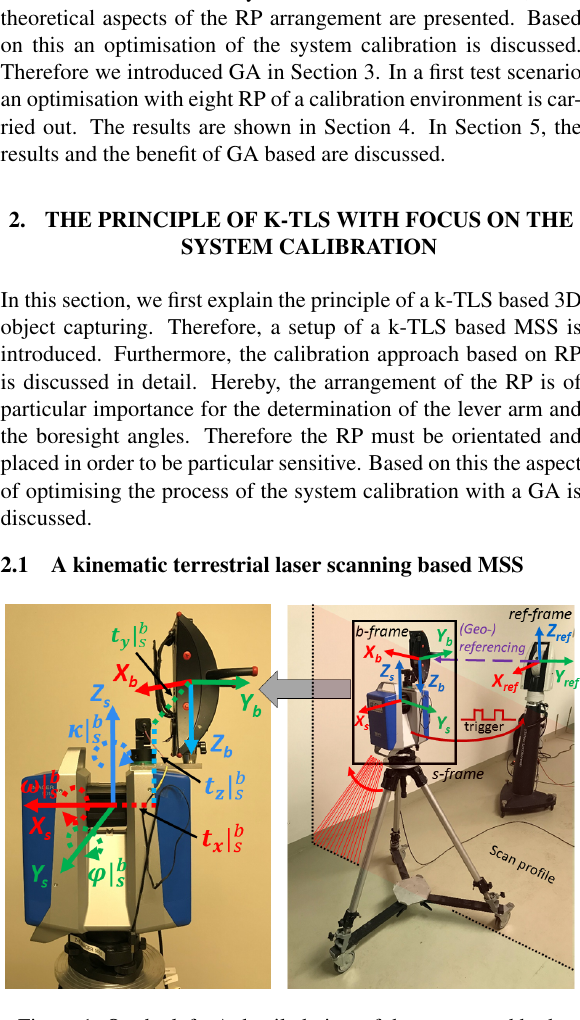
Figure 1. On the left: A detailed view of the sensor and body frame as well as the lever arm and boresight angles. On the right: The principle of the k-TLS based MSS as well as the sensors and their corresponding coordinate